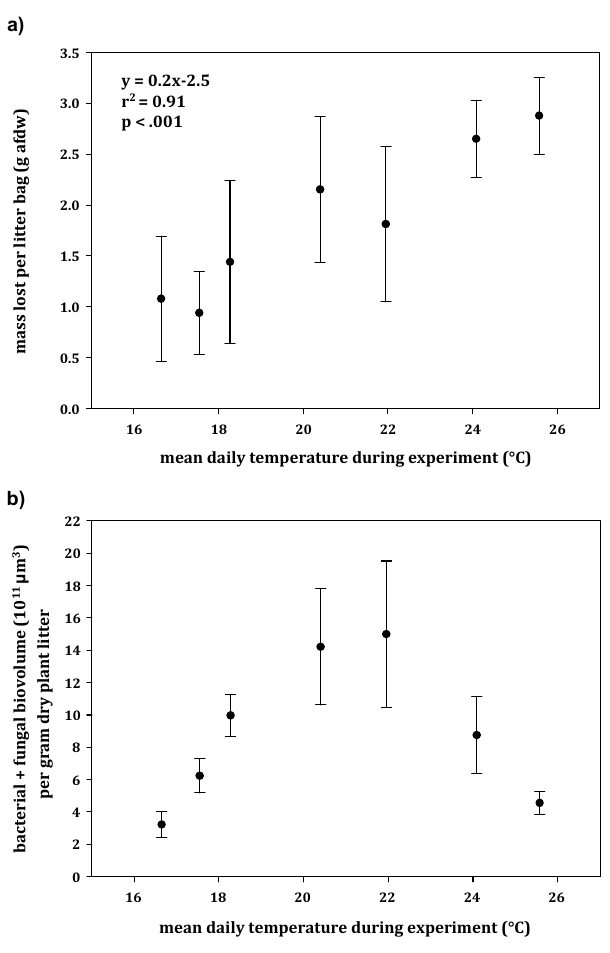
Fig. 2. (a) Relationship between mean daily temperature and or- ganic matter decay rate measured in litterbags. Each litterbag ini- tially contained 10.0g of dry Spartina alterniflora material, and was subjected to 4 weeks of incubation, beginning one week apart. Each point represents the mean mass loss, and error bars represent the standard deviation, of 5 litterbag replicates during each incubation period. (b) Relationship between total microbial biovolume and mean daily temperature derived from fungal and bacterial counts on litter remaining at the end of each four-week experiment. In these experiments, the size of fungal hyphae dominates the size of bac- teria, but neither bacterial or fungal abundance shows a statistically significant linear relationship with temperature. This suggests that the organic decay rate is controlled primarily by temperature and not the type or abundance of the microbial